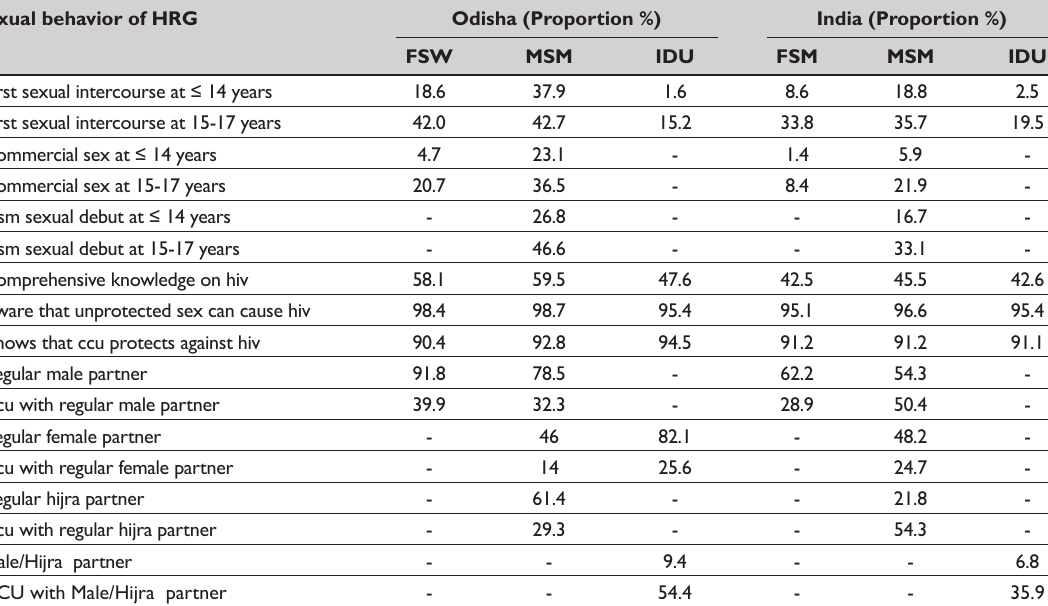
Table 3: Sexual behavior among high-risk group in Odisha (Sourced from Integrated Behavioral and Biological Surveillance conducted among high-risk groups during 2014-2015) Sexual behavior of